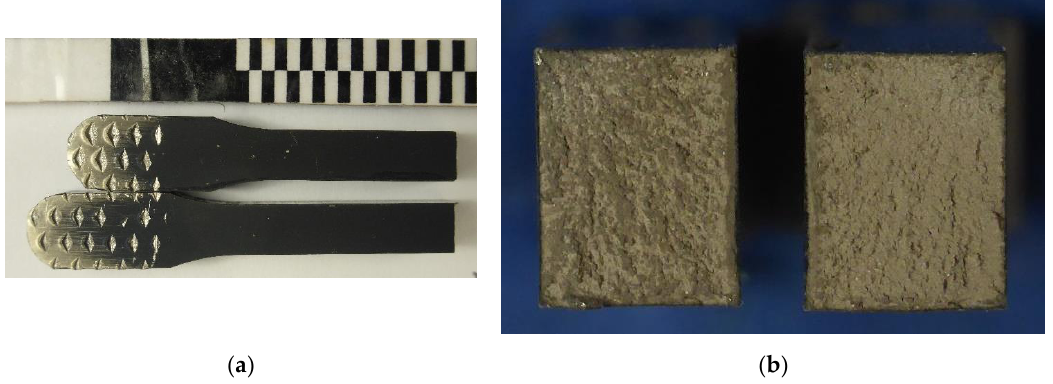
Figure 5. ( a ) Longitudinal and ( b ) cross-section of tensile specimen C tested at 250 °C.